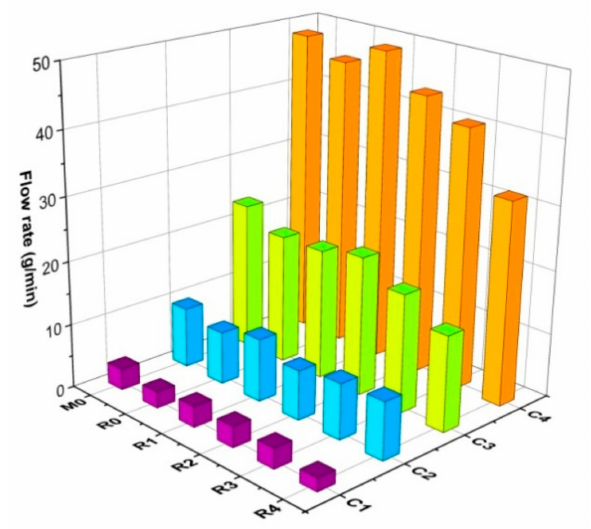
Figure 8. Flow rate of sealing grease at 22.5 ◦